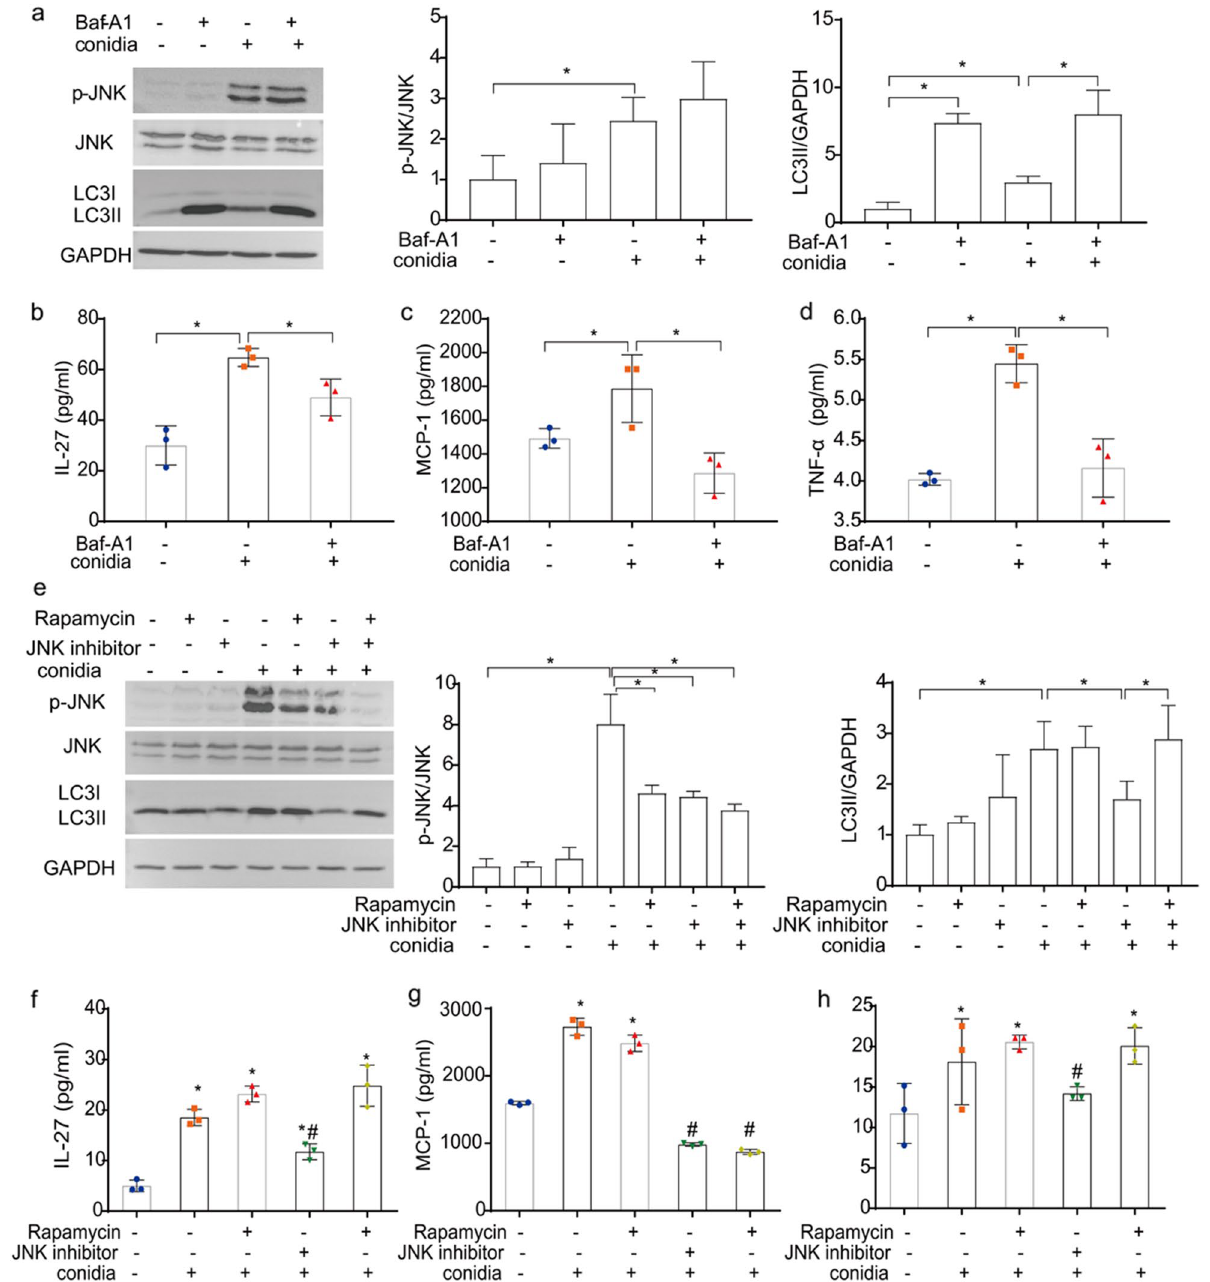
Figure 5. Involvement of autophagy in the release of inflammatory factors in bronchial epithelial cells by A. fumigatus conidia exposure. Prior to inoculation with A. fumigatus conidia for 8 h, BEAS-2B cells were treated with 10 nM Baf-A1 or 100 nM Rapamycin for 12 h. The expression of p-JNK, JNK and LC3II was detected by western blotting. The blots were cut prior to hybridisation with antibodies during blotting ( a , e ). The secretion of IL-27, MCP-1 and TNF-α in supernatant of each group was detected ( b – d , f – h ). Data are presented as mean ± SD (* P < 0.05 versus control group, # P < 0.05 versus conidia stimulation